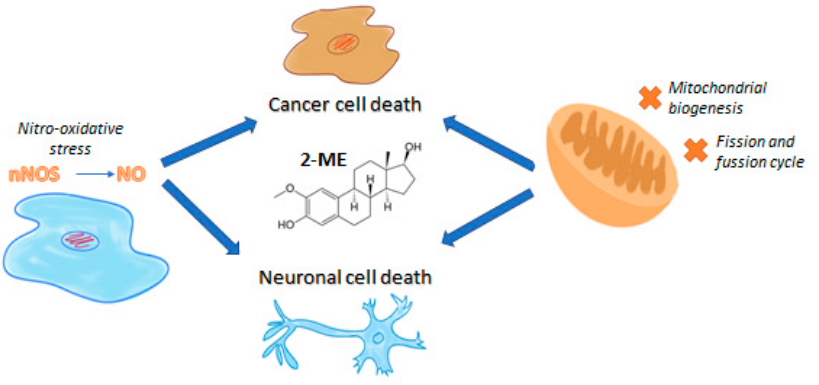
Figure 1. The anticancer mechanism of 2-ME and its plausible neurodegenerative features.